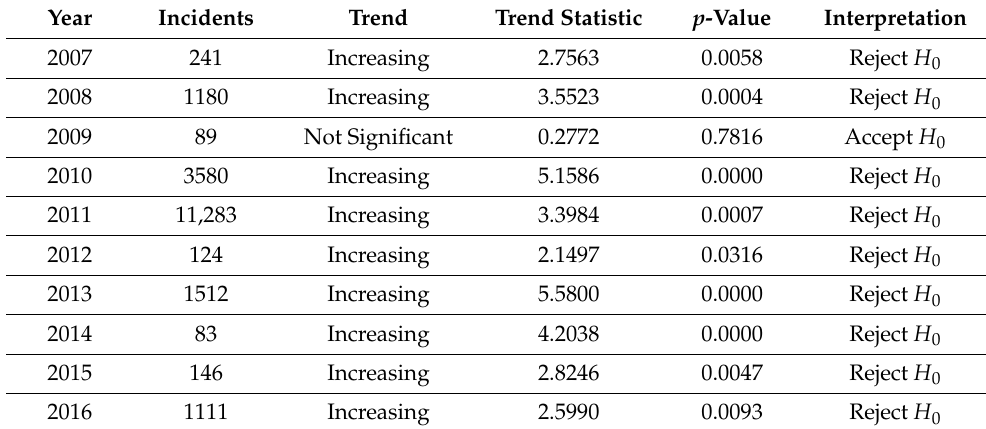
Table 2. Mann–Kendall trend test showing dengue’s space–time trend from 2007 to 2016. Year Incidents Trend Trend Statistic p -Value Interpretation 2007 241 Increasing 2.7563 0.0058 Reject H 0 Increasing 3.5523